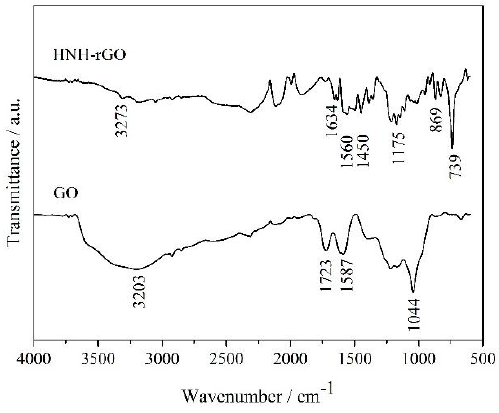
Figure 6. The Fourier transform infrared (FTIR) spectra of GO and HNH-rGO.